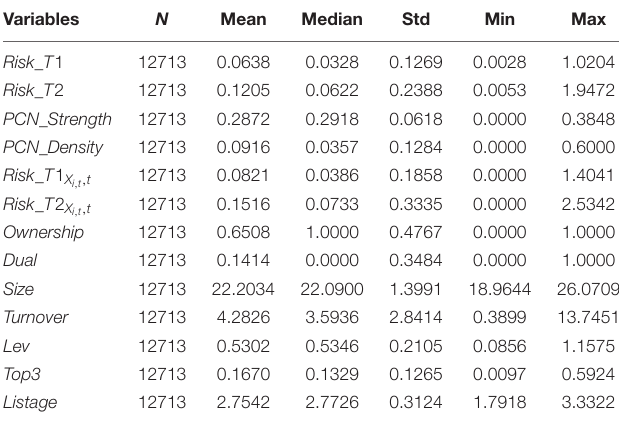
TABLE 2 | The descriptive statistics of variables.